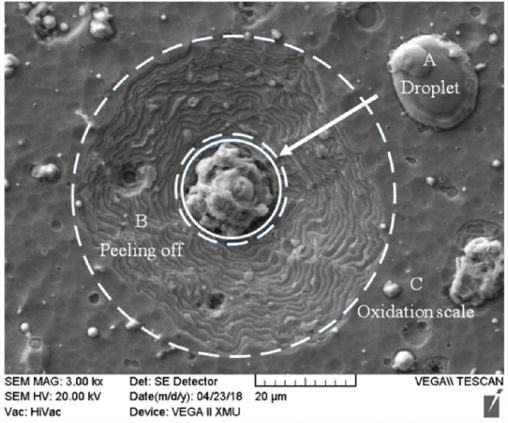
Figure 20. SEM image of TiN/ZrN coating after hot corrosion for 88 h.